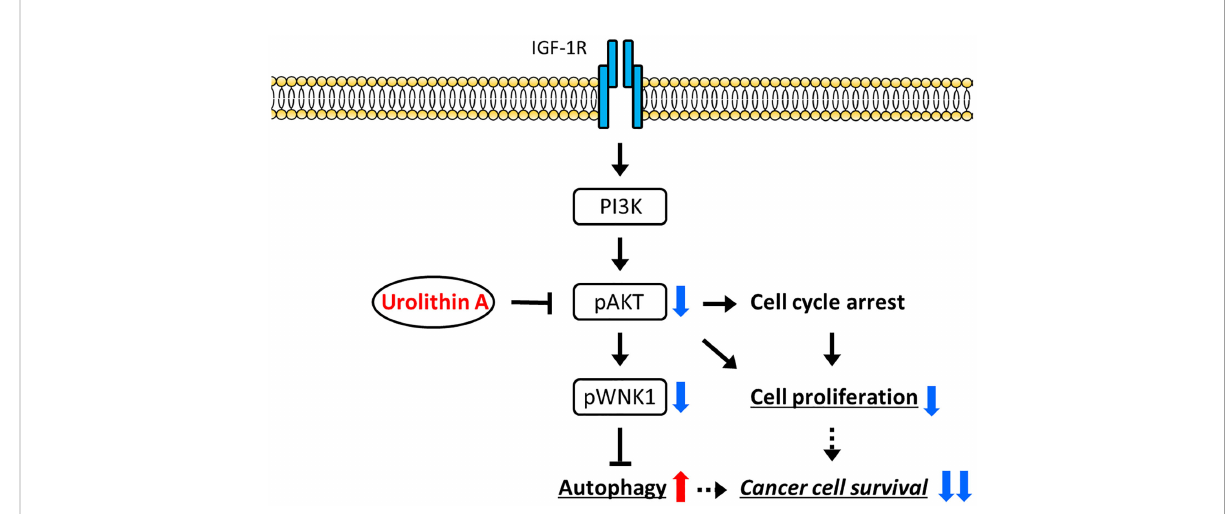
FIGURE 6 A proposed model of the mechanism. UA treatment reduces cell proliferation by inhibiting the activation of AKT, and inducing autophagy via the WNK1 pathway. As a result, cancer cell survival is suppressed by UA in cholangiocarcinoma